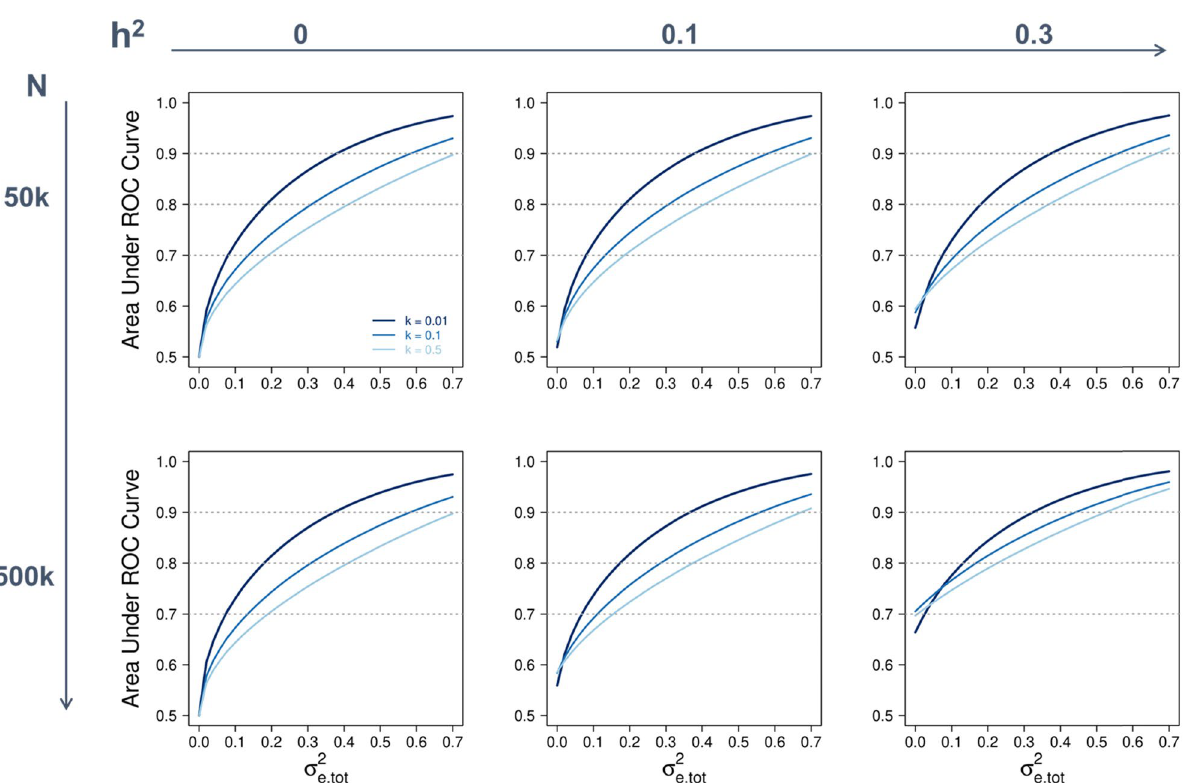
Figure 5. Expected prediction accuracy of the proposed integrative analysis of genetic and exposomic data for disease traits of different prevalence (k) and heritability (h 2 ) at varying levels of total variance explained 2 by the exposome ( σ e . tot ) and sample size of the discovery dataset (N). Diseases are assumed to have a liability 2 of mean zero and variance 1, and both h 2 and σ e . tot are on the disease liability scale. Prediction accuracy is measured using the area under the receiver operating characteristic (ROC) curve, with 0.7 to 0.8 generally being considered acceptable, 0.8 to 0.9 excellent, and above 0.9 outstanding. The assumed effective number of chromosome segments and the number of exposomic variables are 50,000 and 28, respectively, which are based on the genomic and exposomic data used in this study. However, varying the number of exposomic variables from 28 to 100 does not have a notable effect on the expected area under the ROC